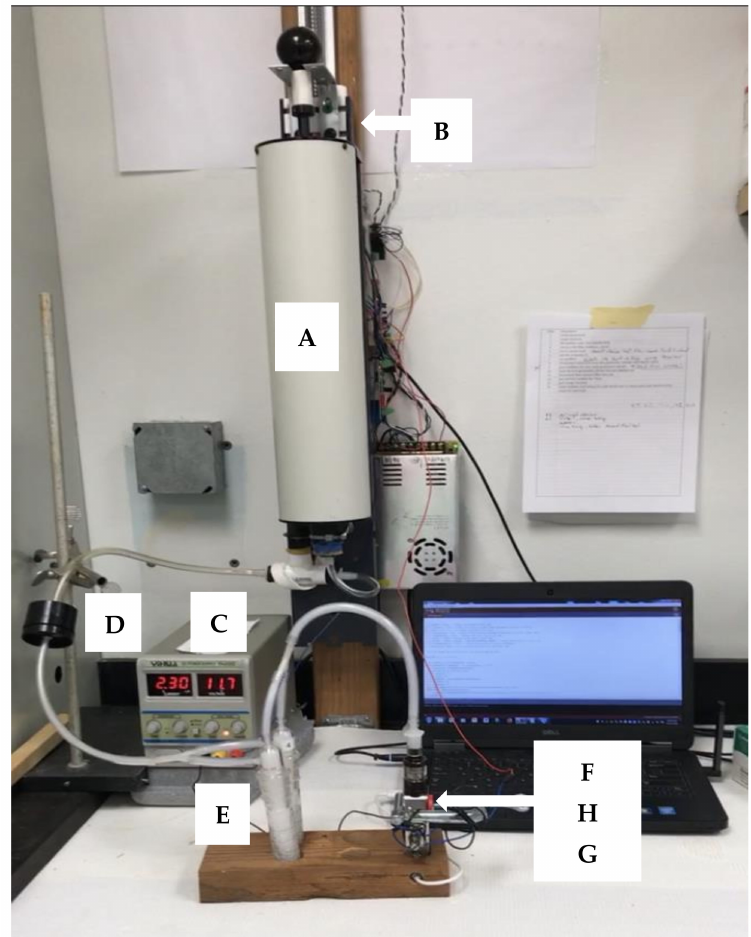
Figure 1. The PUFF3rd puffing machine setup with parallel midget bubblers for the intermediate flow rate of 3000 mL/min. Higher flow conditions (4500 and 6000 mL/min) used a 125 mL gas washing bottle. The lower condition (1100 mL/min) used a single midget bubbler. ( A ) 3 L spirometer syringe, ( B ) stepper motor, ( C ) adjustable DC power supply, ( D ) filter holder, ( E ) bubbler(s), ( F ) atomizer, ( G ) battery system and ( H ) clamp-on button